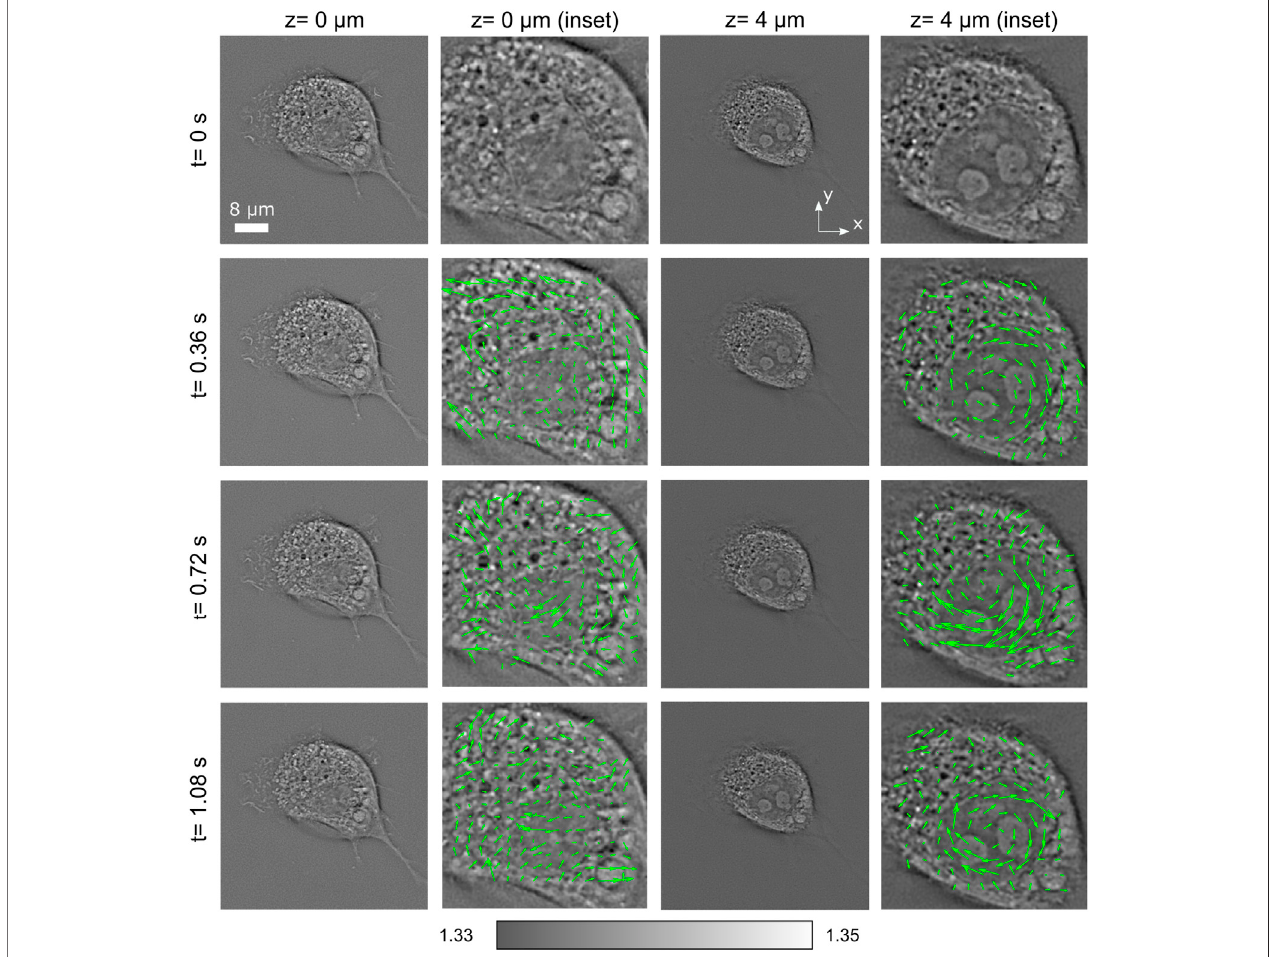
FIGURE 3 | Short-term evolution of RI slices of a living COS-7 cell, alongwith aspeed map plot representing the velocity fi eld of the cell structures. The speed fi eld magnitude is variable within the range 0.18 – 1.4 μ m/s. Certain tendency to vorticity is particularly noticeable at z (cid:2) 4 μ m.